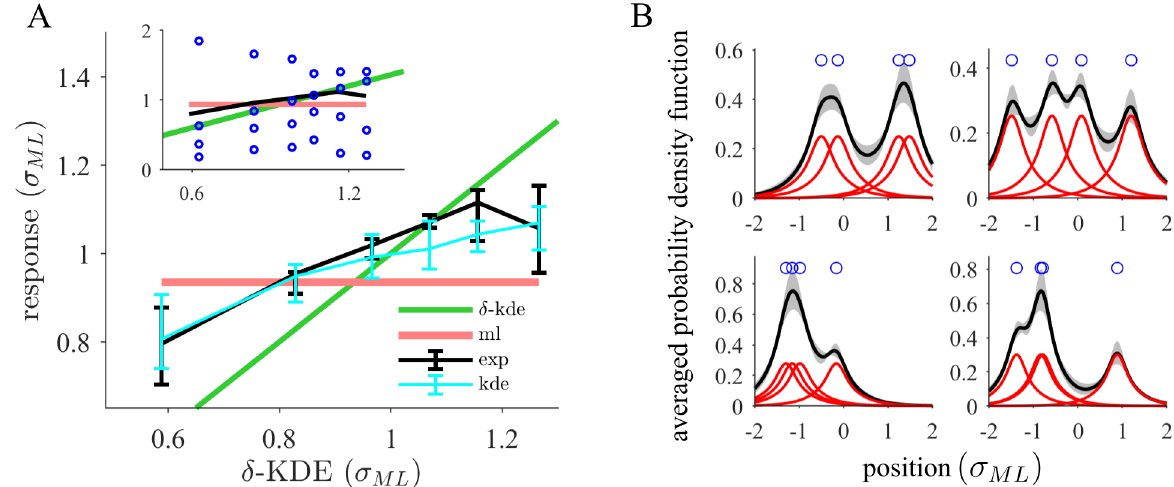
Fig 7. Strong generalization is consistent with the possibility of integrating prior knowledge about the task structure. (A) Responses (black) show higher consistency with inference of a single Gaussian than with approaches generalizing only weakly beyond the sample such as δ -KDE (limit of vanishing kernel widths; third most excentric sample point). The plot shows aggregated (median across participants, 95% CI) bin medians of the responses (normalized by σ ) and the fitted KDE model (cyan) as a function of the δ -KDE output (approximately equally filled ML bins). By construction, inference of a Gaussian results in a horizontal line (red) while δ -KDE (green) yields a linear function of slope one. The experimental curves are less steep indicating a rather moderate instance-based modulation compared to a Gaussian model. The inset is a zoomed- out version additionally showing the relationship of the responses to the distribution of sample points (median of absolute value within each bin). (B) The KDE model infers internal distributions that are smoothed and spatially extended around the sample points. The mean probability density function across participants (black, 95% CI) is shown for four different samples (blue circles). The inferred density is smooth featuring fewer modes than the number of basis distributions (red curves). This is a consequence of the large fitted Gaussian kernel widths which lead to substantial overlap of the basis